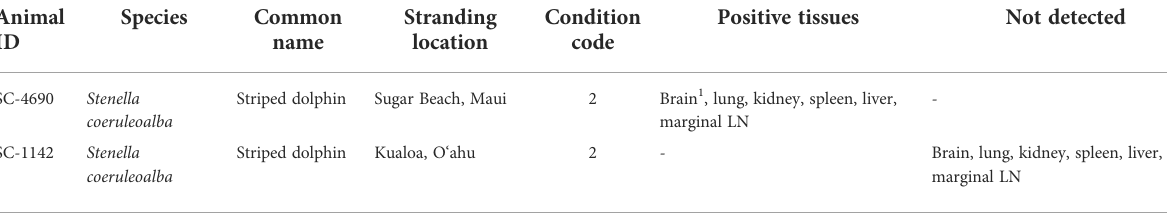
Blainville ’ s beaked whales (n=1), sperm whales (n=1), dwarf sperm whales (n=1), spinner dolphins ( Stenella longirostris ) (n=3), striped dolphins ( Stenella coeruleoalba ) (n=1), Fraser ’ s dolphins ( Lagenodelphis hosei ) (n=1), melon-headed whales (n=1), false killer whales (n=1), and short- fi nned pilot whales (n=2, both from a single mass stranding event) (Table 2).